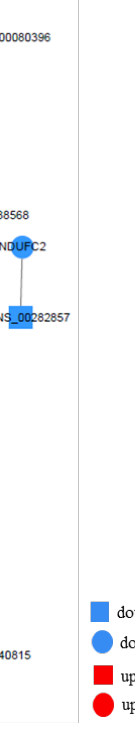
Figure 5. Expression regulation network constructed by differentially expressed mRNA-lnRNA.